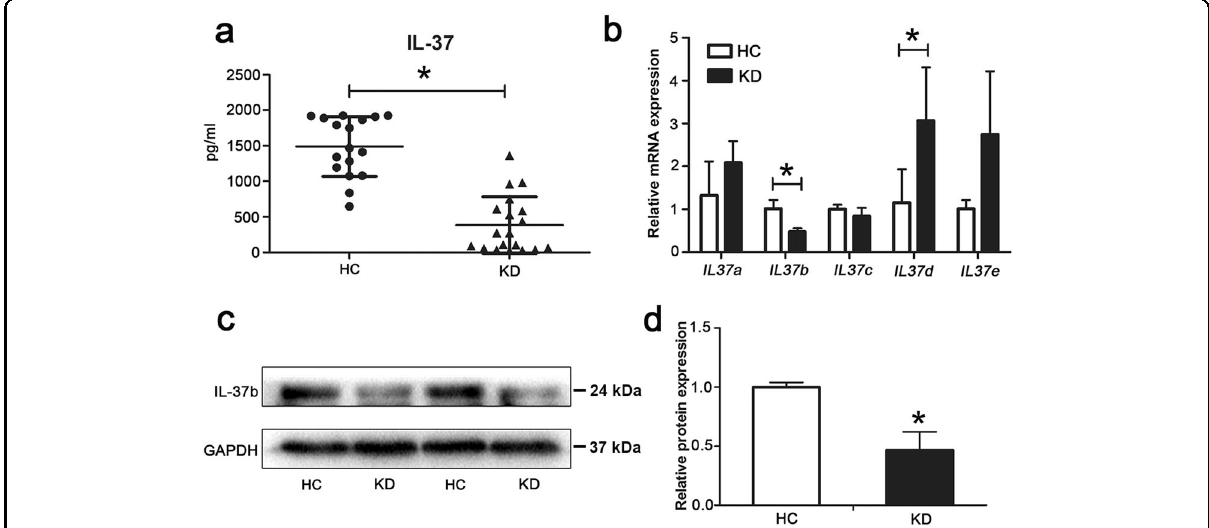
Fig. 1 The expression level of IL-37b was decreased after KD sera treatment. a The levels of IL-37 in sera from health controls (HCs, n = 17) and KD patients ( n = 18) were evaluated by enzyme-linked immunosorbent assay (ELISA). Signi fi cance: * P < 0.05. b The mRNA expression levels of fi ve IL- 37 splice variants (IL-37a – e) were evaluated in KD-treated ECs by qRT-PCR analysis. Signi fi cance: * P < 0.05. c , d Protein expression of IL-37b was assessed in KD-treated ECs by western blot analysis. GAPDH was used as an internal control. Quantitative analysis of IL-37b expression was performed ( d ). All these experiments were repeated at least three times. Data are shown as mean ± SD ( n = 3). Signi fi cance: * P <